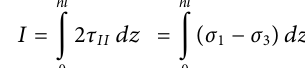
Frontiers in Earth Science |